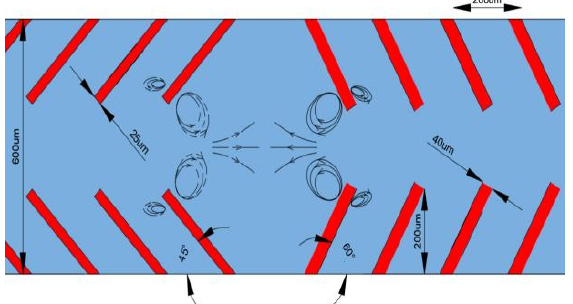
Figure 3. Schematic of PDMS sharp-edge structure layer and working mechanism of acoustic micropump.